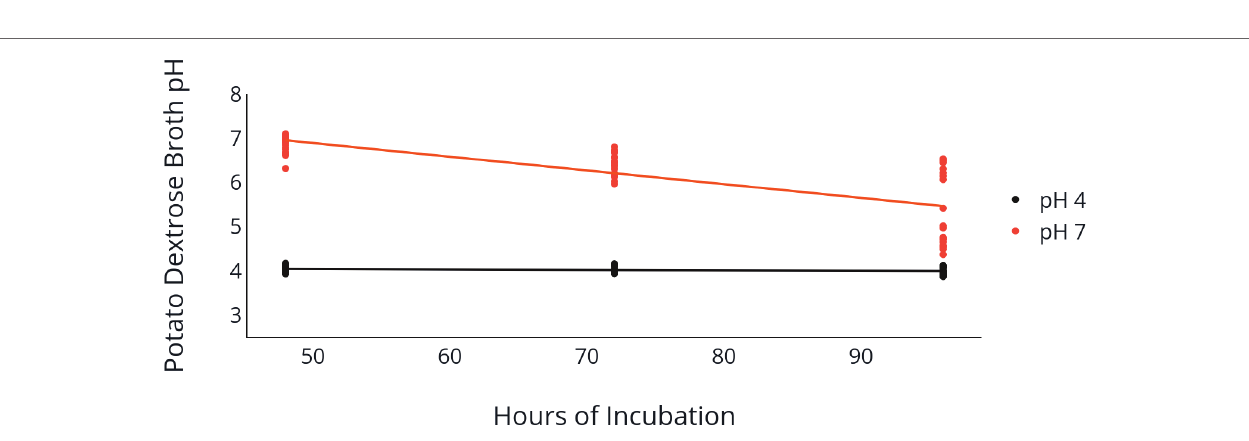
FIGURE 3 | Medium pH following C. jacksonii inoculation. Change in PDB pH following incubation of two C. jacksonii isolates set at an initial pH of 4 or 7. PDB pH was measured at 48, 72, and 96 h following placement of C. jacksonii in the broth. No isolate differences were observed, so the results were combined. The orange trendline indicates the decline in pH in flasks initially adjusted to a pH of 7 ( p < 0.0001, y = − 0.031 x + 8.45, R 2 = 0.577). The black trendline indicates the decline in pH in flasks initially adjusted to a pH of 4 ( p = 0.078, y = − 0.001 x + 4.09, R 2 =